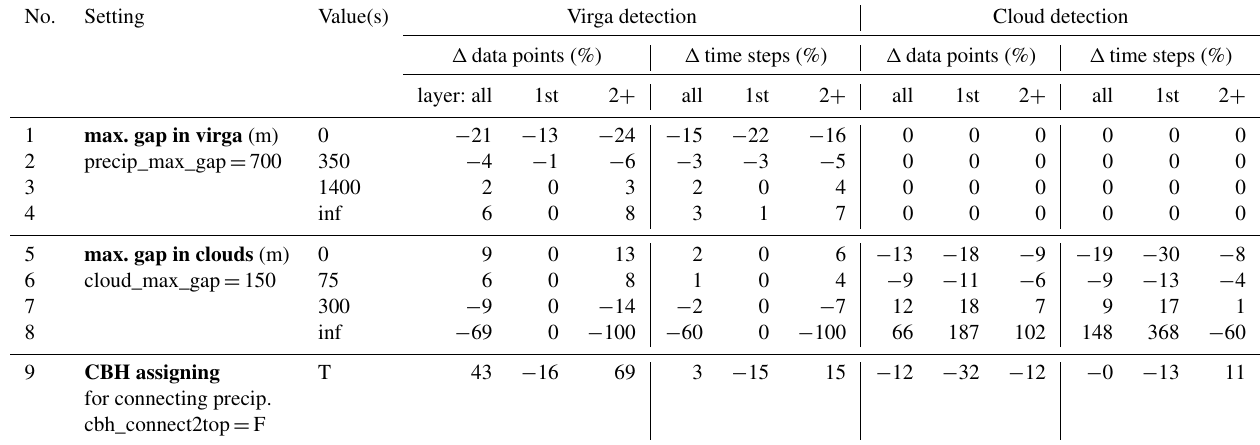
Table B2. As Table B1 but for thresholds and settings for virga and cloud detection and virga mask refinement. No.